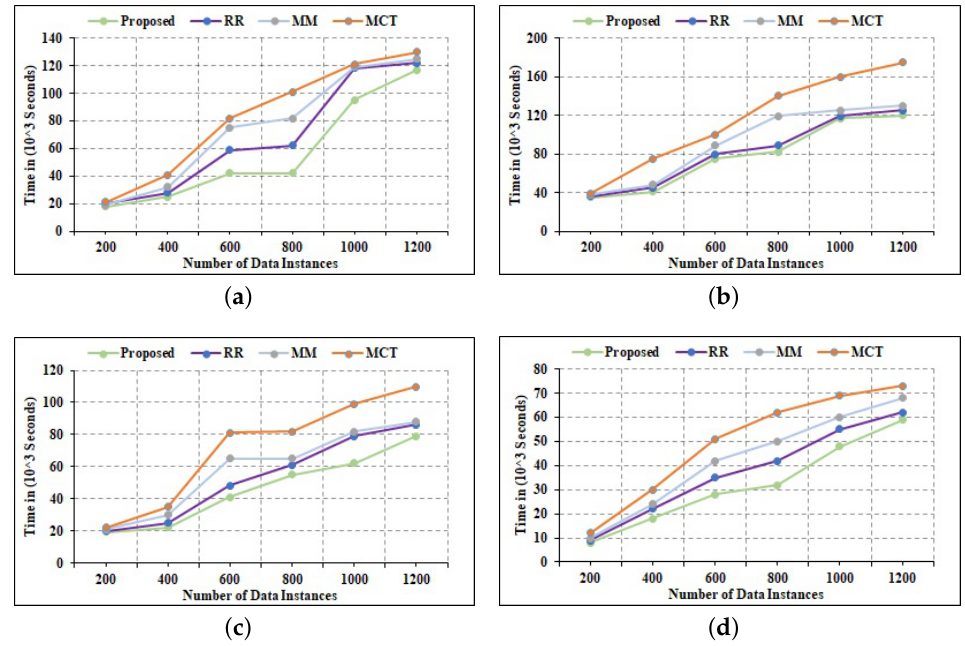
Figure 11. Comparative Analysis of Temporal Delay Efficiency. ( a ) 6 Edge Nodes; ( b ) 10 Edge Nodes; ( c ) 14 Edge Nodes; ( d ) 20 Edge